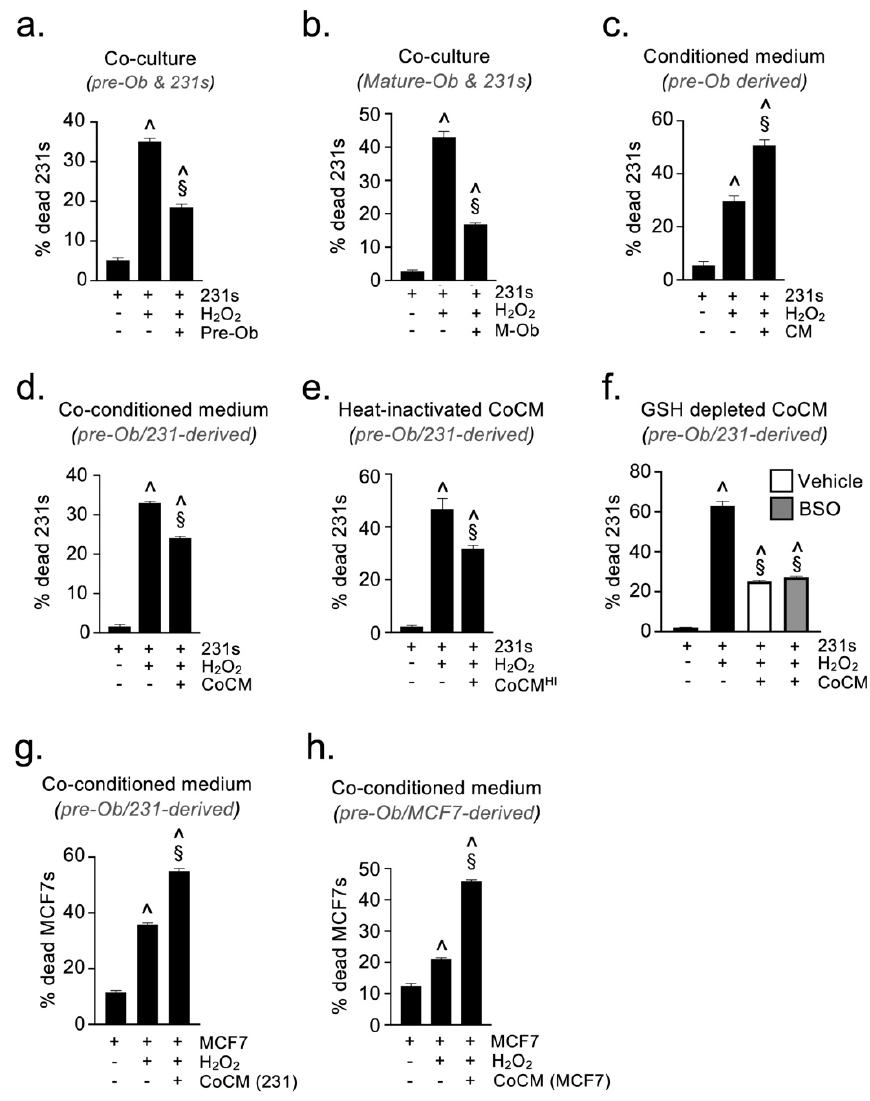
Figure 4. Paracrine cross talk with osteoblasts protects hormone receptor negative BCCs from oxidative stress-induced cell death. Flow cytometric quantification of tumor cell viability in oxidative stress assays performed using MDA-MB-231 BCCs in the presence of ( a ) pre-osteoblasts, ( b ) mature osteoblasts ( c ) pre-osteoblast conditioned medium, ( d ) pre-osteoblast and MDA-MB-231 co-conditioned medium, ( e ) heat-inactivated co-conditioned medium, ( f ) glutathione-depleted co-conditioned medium. Oxidative stress assays performed using MCF7 BCCs in the presence of ( g ) pre-Ob and MDA-MB-231 co-conditioned medium and ( h ) pre-Ob and MCF7 co-conditioned medium. (CM = conditioned medium, CoCM = pre-Ob and BCC co-conditioned medium, HI-CoCM = heat-inactivated pre-Ob and BCC co-conditioned medium, CoCM(231) = co-conditioned medium from MDA-MB-231, CoCM(MCF7) = co-conditioned medium from MCF7, M-Ob = mature osteoblasts; ˆ sig. dif. w.r.t. untreated BCCs ( p < 0.0001), § sig. dif. w.r.t. BCCs + H 2 O 2 ( p < 0.01); n =